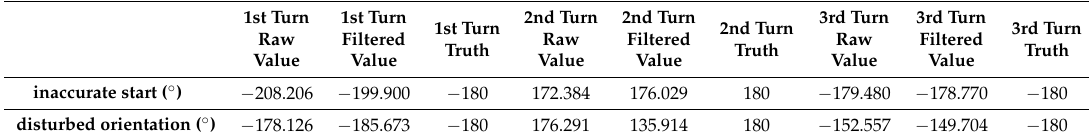
Table 5. Angle differences of heading in Route 2.